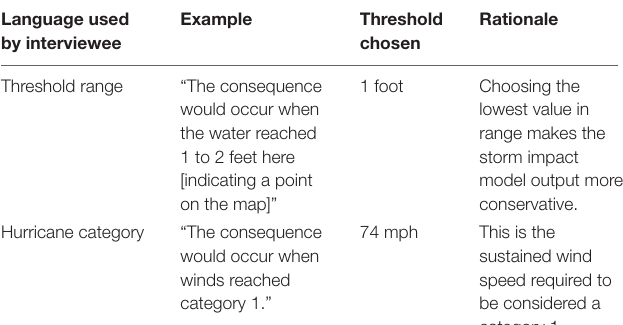
TABLE 2 | Standardization of interviewee’s threshold component